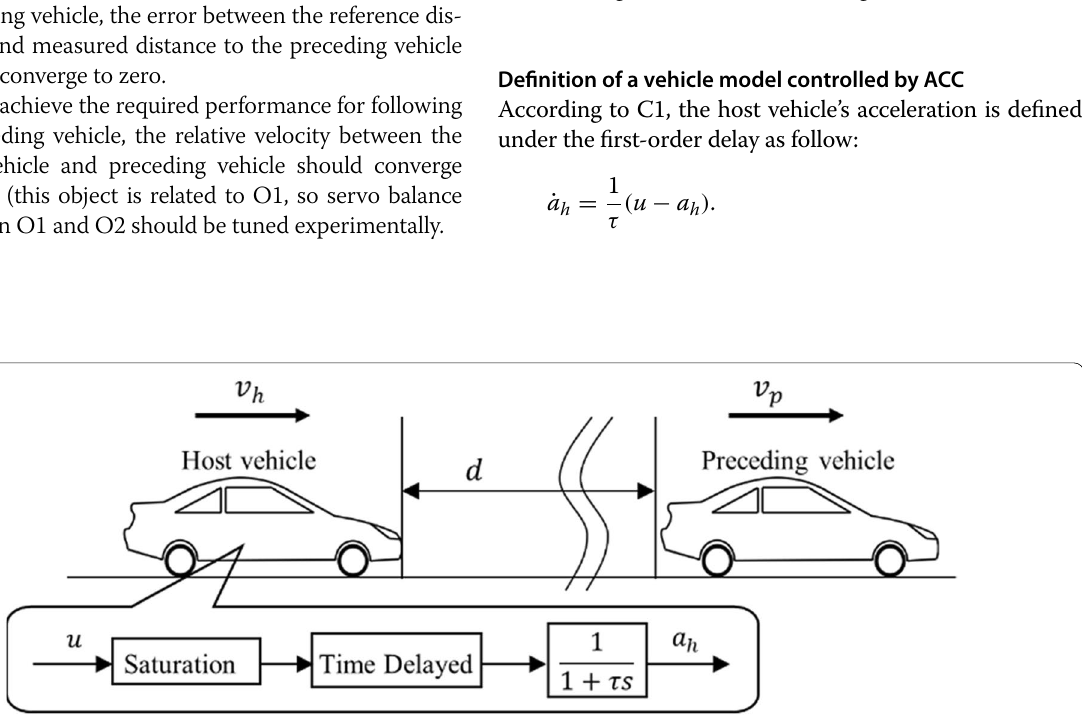
Fig. 1 Scenario for ACC